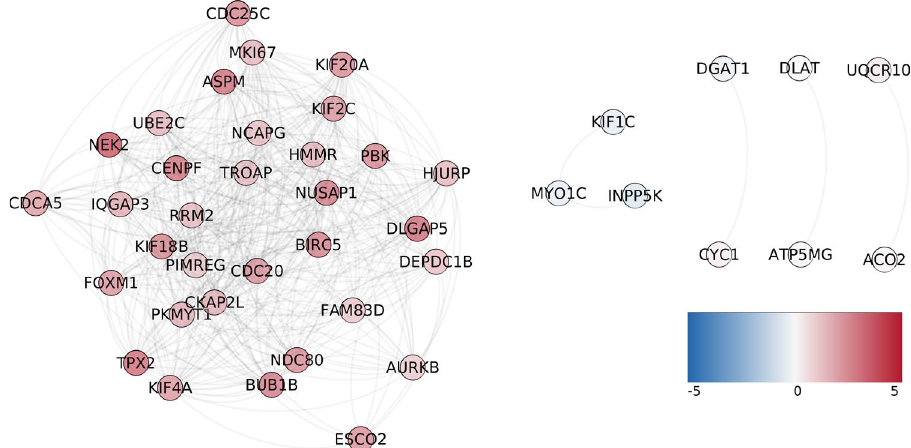
Figure 9. Intersection between healthy and LumA 30 networks. This network shows the shared interactions between the aforementioned networks. Genes are colored according to its differential expression LogFC value: red genes are overexpressed, while blue genes have negative LogFC values. Importantly, this cluster is composed of only trans-